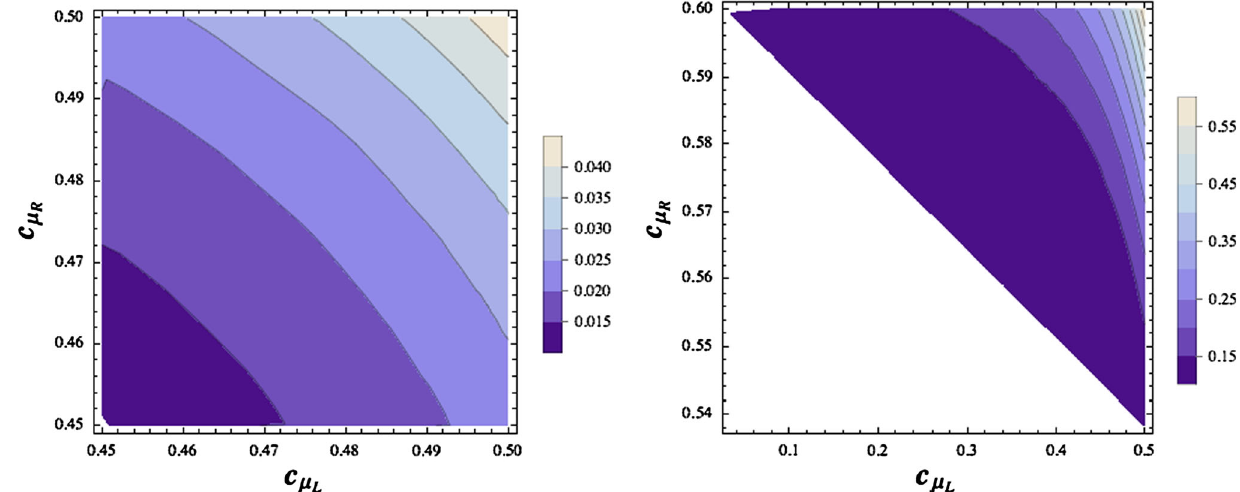
− c μ plane for Scenario A (left) and Scenario B L R